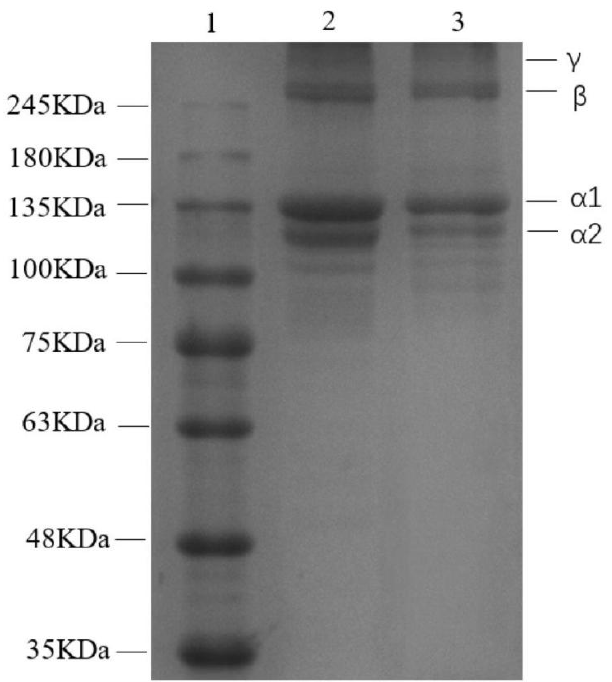
Figure 1. Patterns of all collagens extracted from Bactrian camel skin, assessed using sodium dodecyl sulfate polyacrylamide gel electrophoresis (1, Standard protein marker; 2, PSC; 3, UPSC).